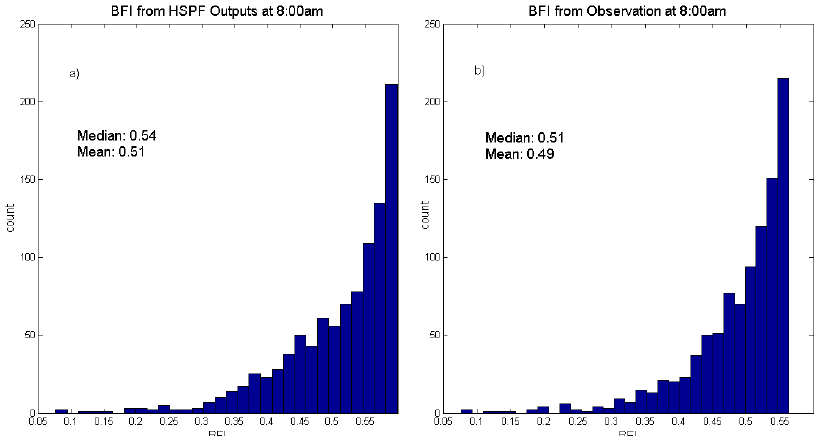
Figure 12. Baseflow index computed from daily 08:00 HSPF output and observations.